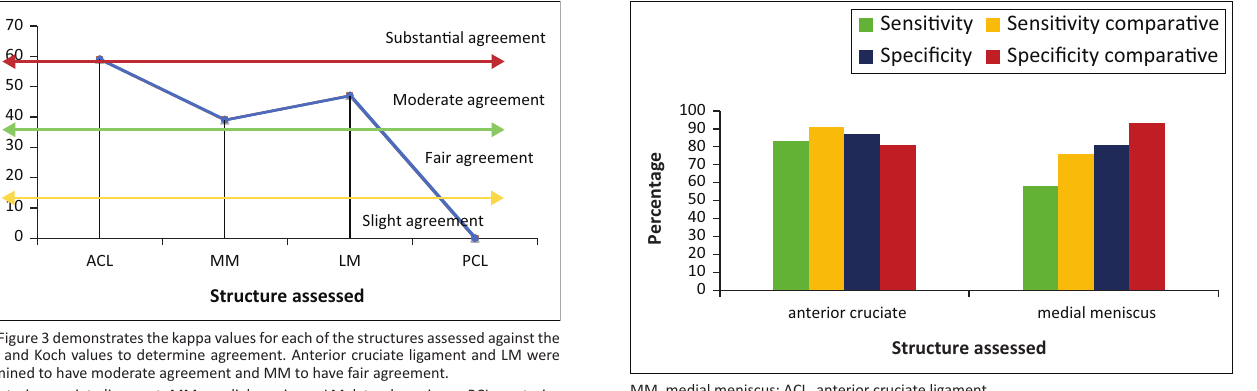
MM, medial meniscus; ACL, anterior cruciate ligament. FIGURE 5: Anterior cruciate ligament and medial meniscus sensitivity and specificity compared to comparative study.